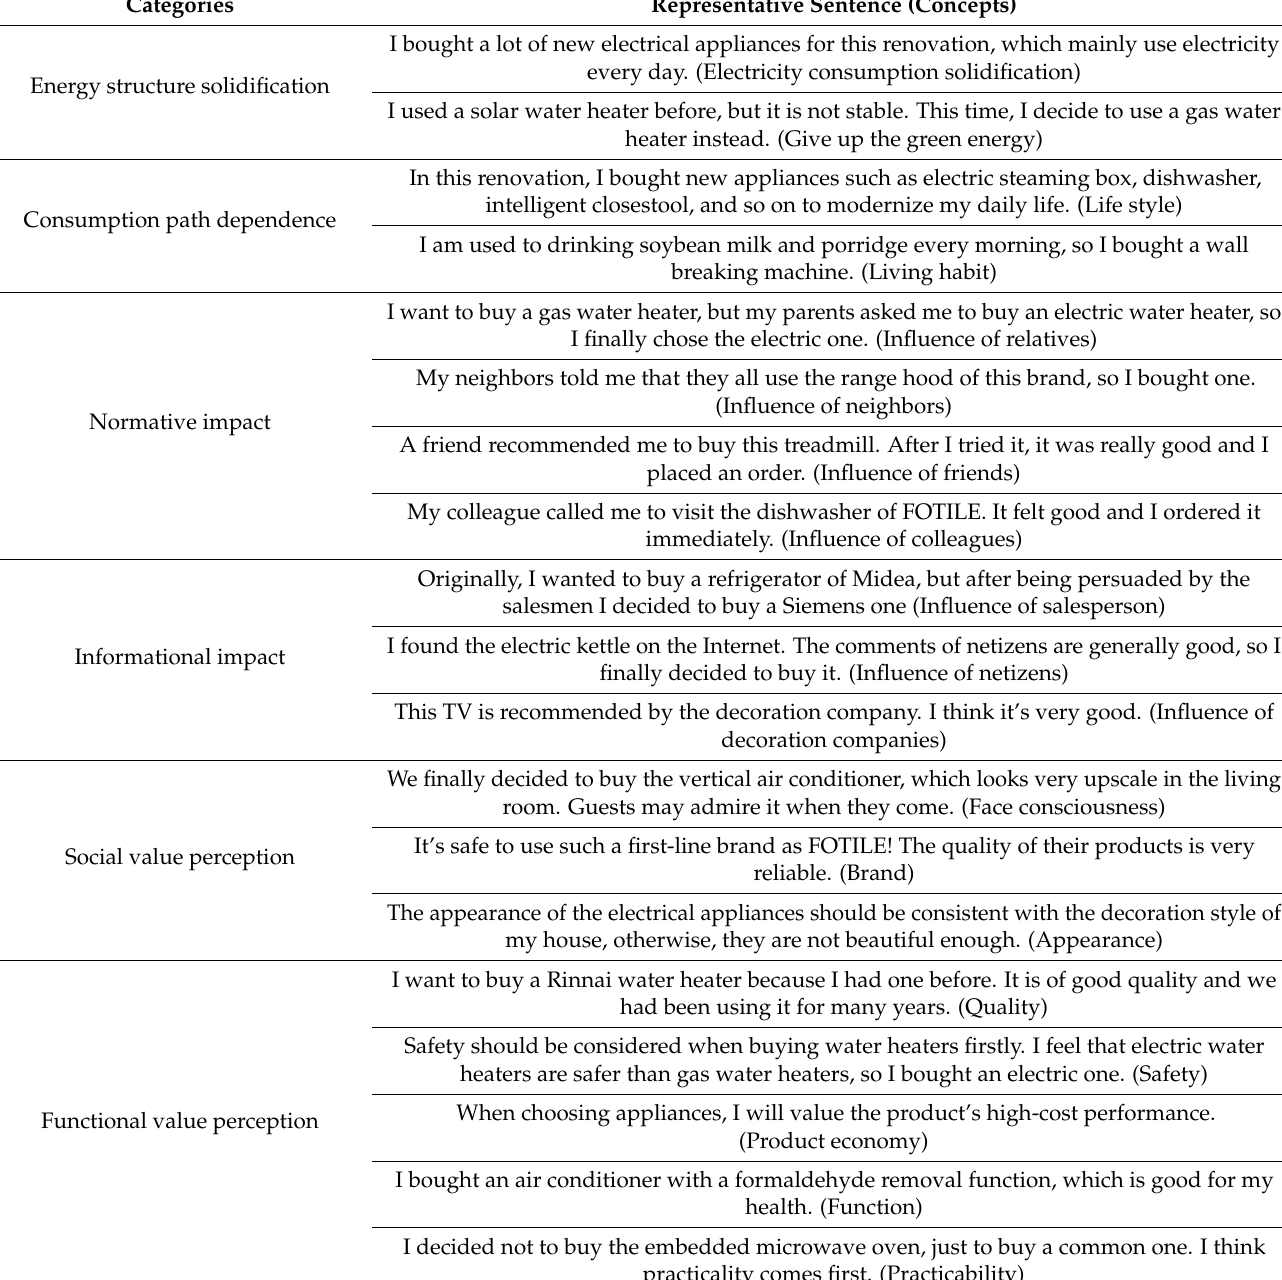
Table 3. Results of open